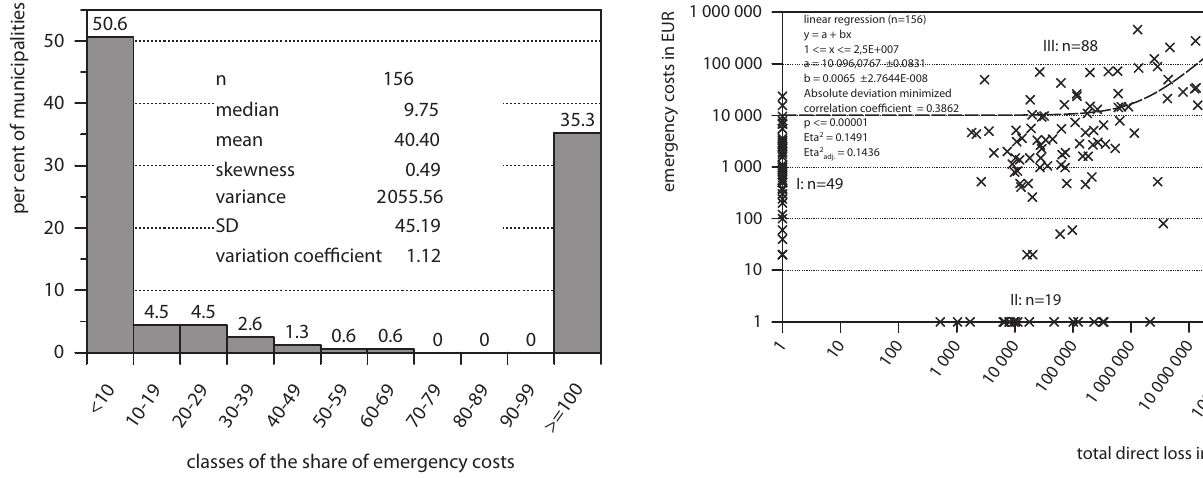
Fig. 6. Histogram of the share of emergency costs in per cent of the total direct losses per municipality (data source: questionnaire results and direct losses of private households and companies pro- vided by the Federal State of Tyrol, Austrian Disaster Fund Act).